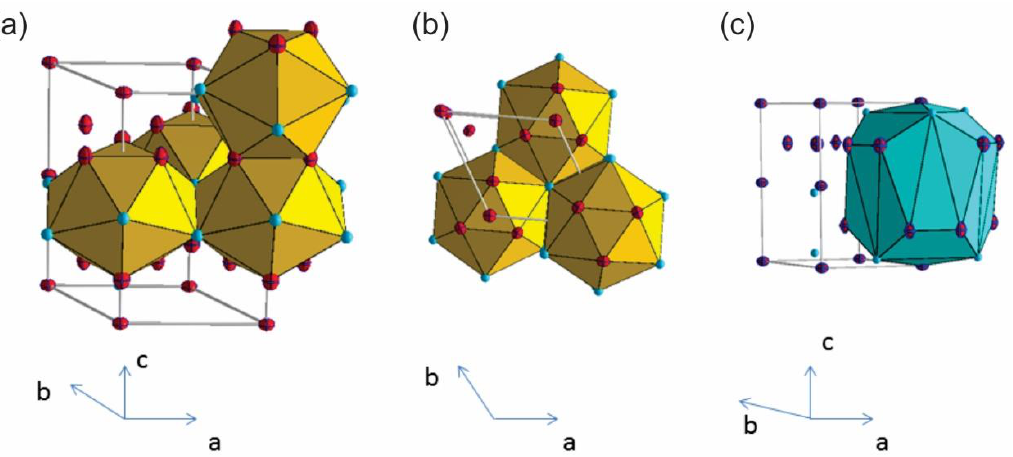
Figure 8. First and second neighbourhoods, with Al/Cr atoms in red and Sc atoms in blue. Left: ( a ) side view, ( b ) top view. Both shells were perfect icosahedra that were connected by edge sharing in the ( a,b ) plane and facet sharing along the c axis. ( c ) Second-neighbour shell around 6h Al/Cr atoms, which formed a pentagonal dodecahedron.